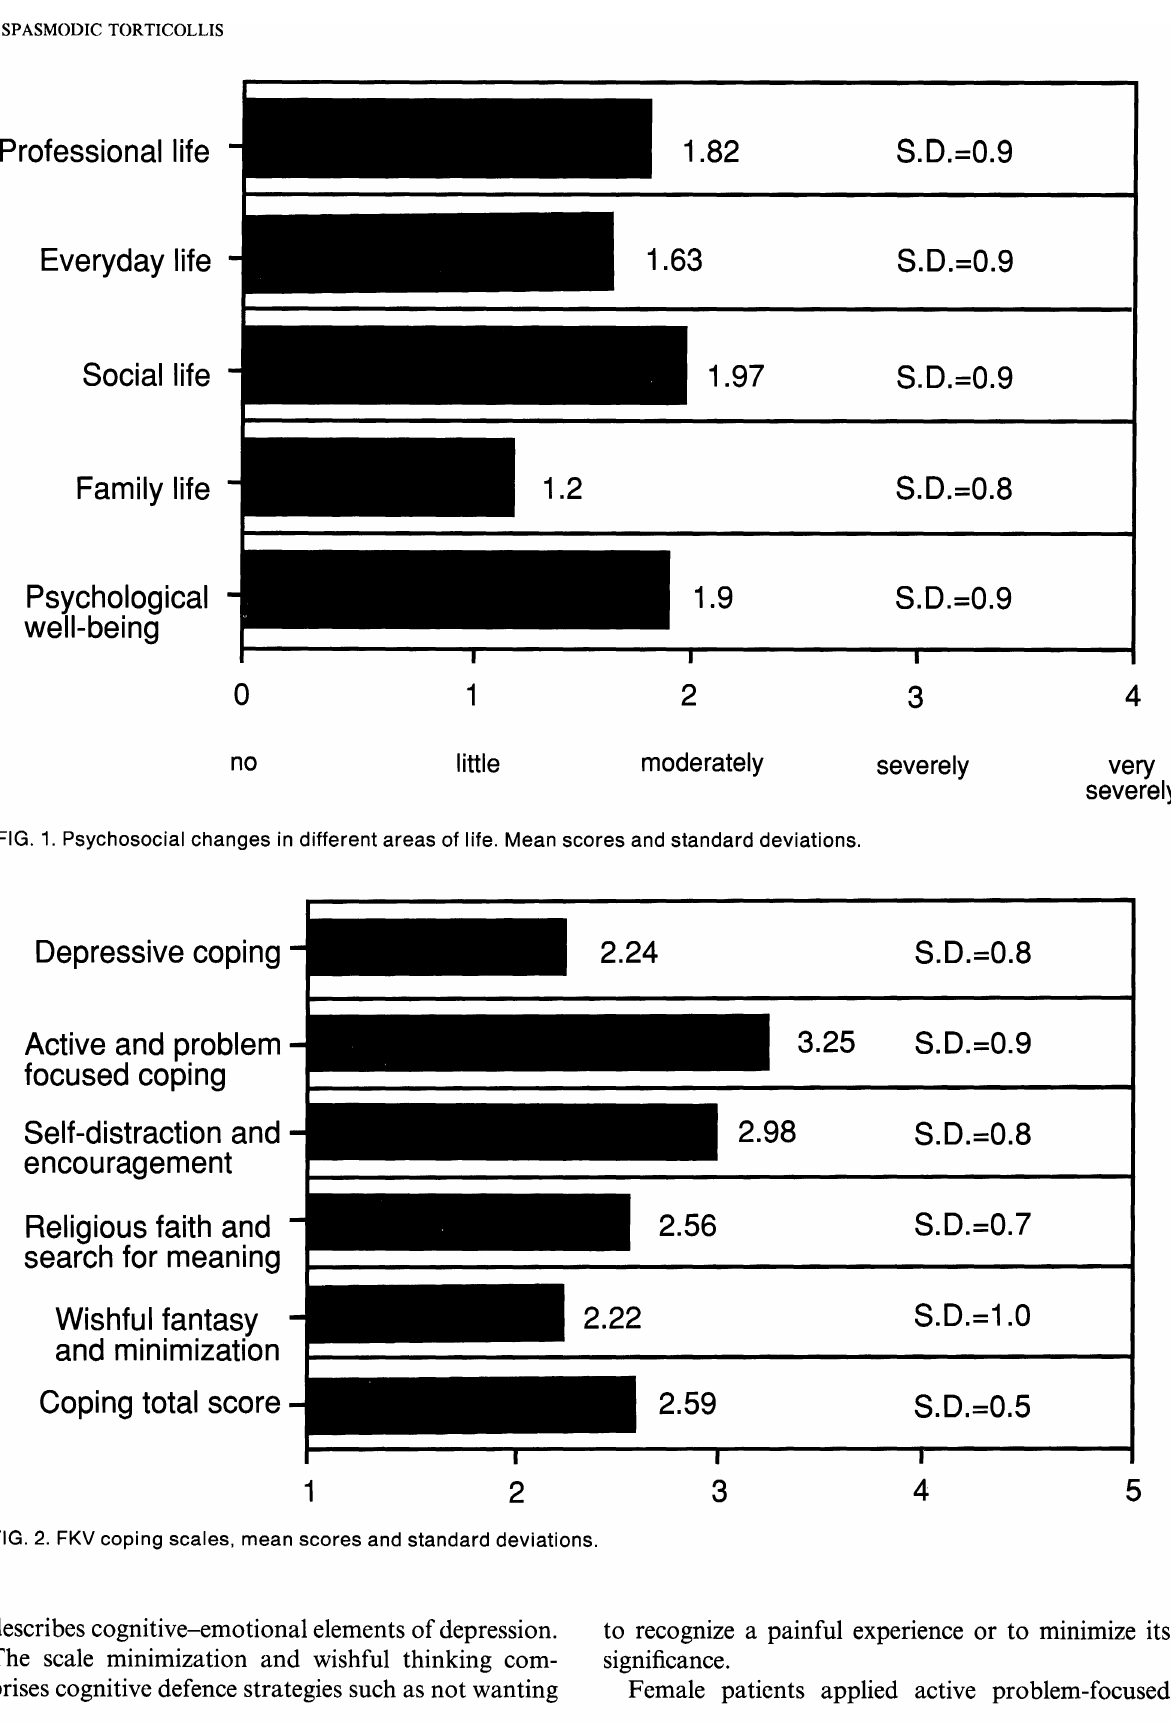
FIG. 2. FKV coping scales, mean scores and standard deviations.